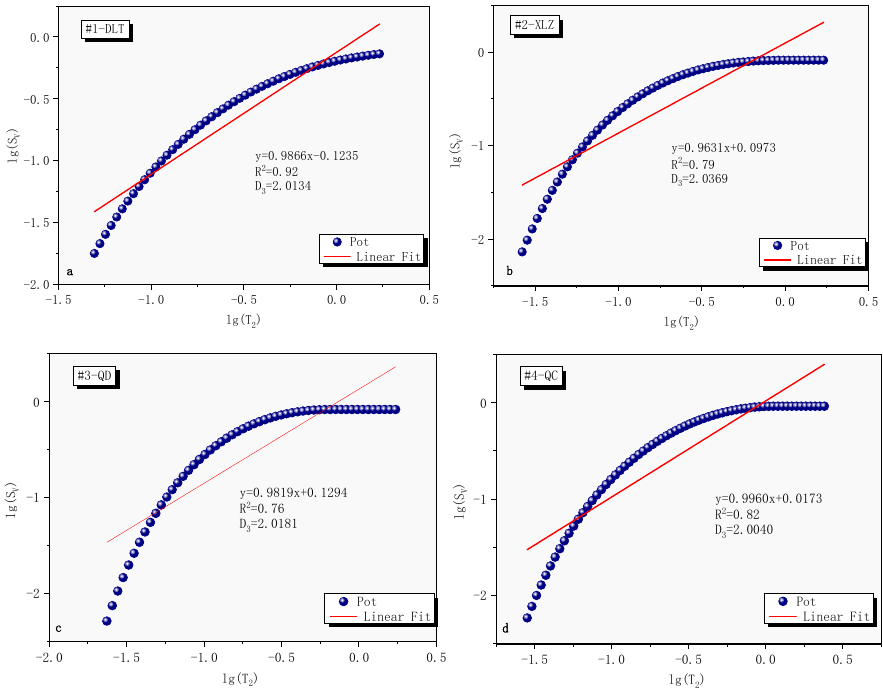
Figure 6. Fitting diagrams of lg ( T 2 ) and lg ( S V ).